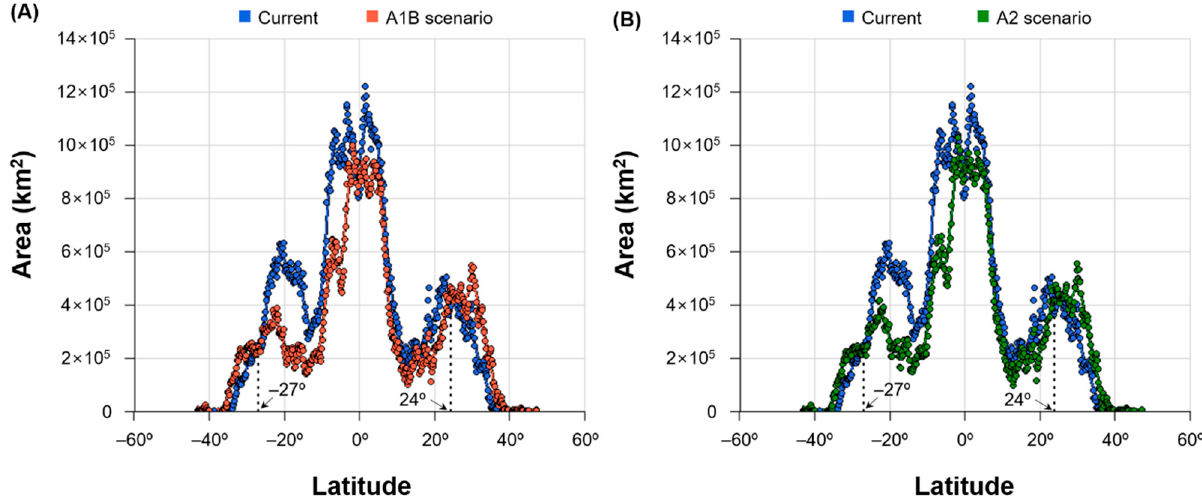
Figure 6. Distribution of favorable habitat areas of S. geminata (climatic suitability > 0.4) according to latitude under current climate and global warming scenarios ( A ) A1B and ( B ) A2 in 2050. Points indicate the total area per latitude and the lines represent smoothing performed by local polynomial regression. Vertical dotted lines show the boundary latitude at which the favorable habitat area of S. geminata is increased by global warming.